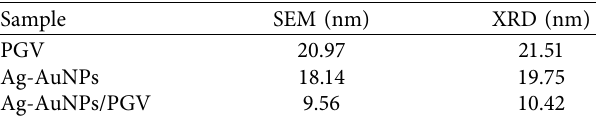
Figure 1: SEM images of PGV bentonite (a), Ag-AuNPs (b), and Ag-AuNPs/PGV bentonite (c) and corresponding distribution size histograms, PGV bentonite (a), Ag-AuNPs (b), and Ag-AuNPs/PGV bentonite (c). Inset: magnification of the SEM images at 5 μ m. Table 1: Comparison between the sizes of PGV, Ag-AuNPs, and Ag-AuNPs/PGV measured by SEM and